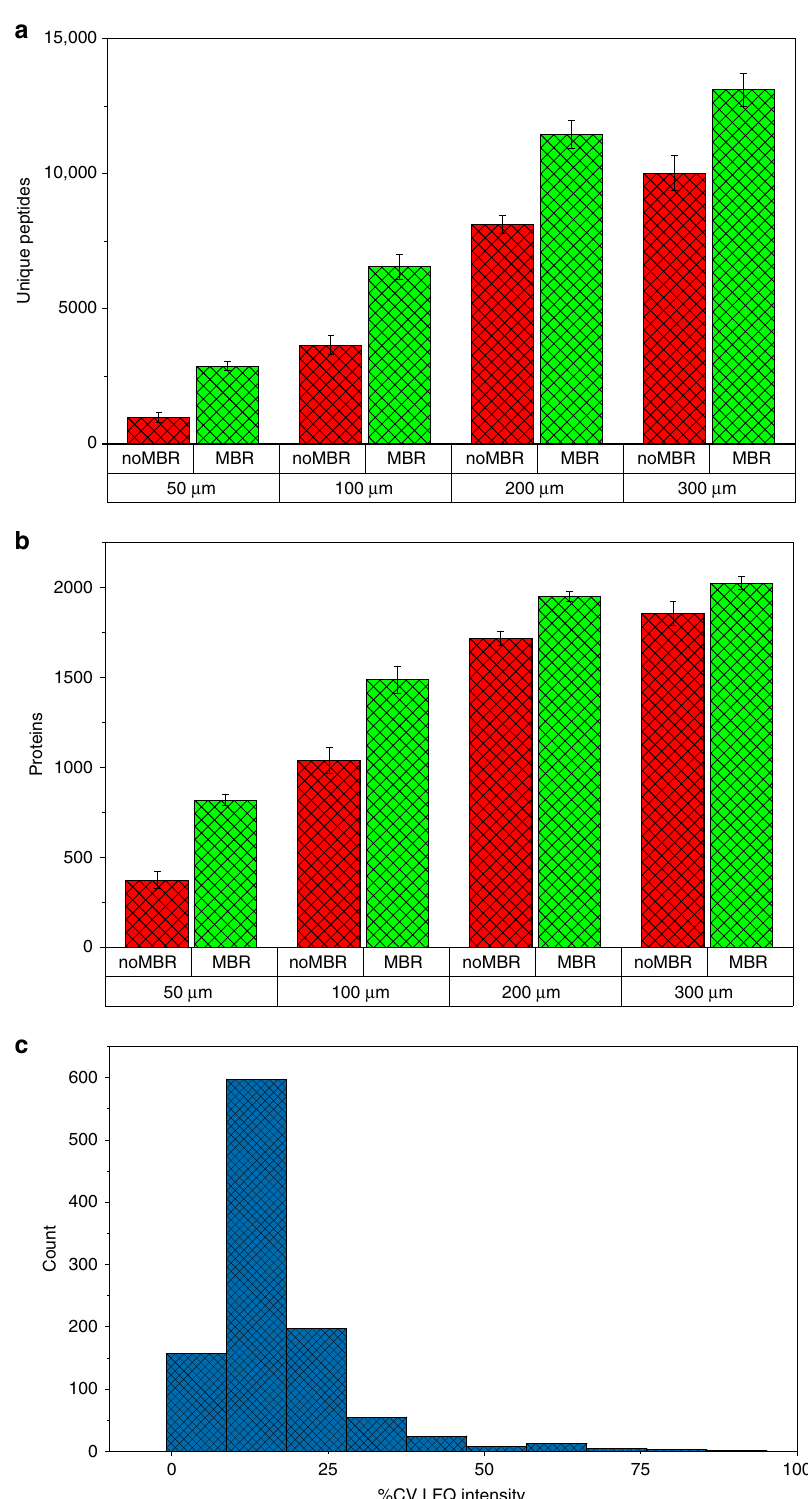
Fig. 2 Reproducibility of nanoPOTS analysis on liver tissue. a Mean number of peptide identi fi cations from four replicate analyses of liver tissue voxels at different lateral resolutions, with and without MBR enabled. b Mean number of protein identi fi cations from four replicate analyses of liver tissue voxels at different lateral resolutions, with and without MBR enabled. c Histogram of protein LFQ intensity coef fi cient of variation (CV) for 20 replicate voxels from homogeneous tissue sections. Error bars, standard